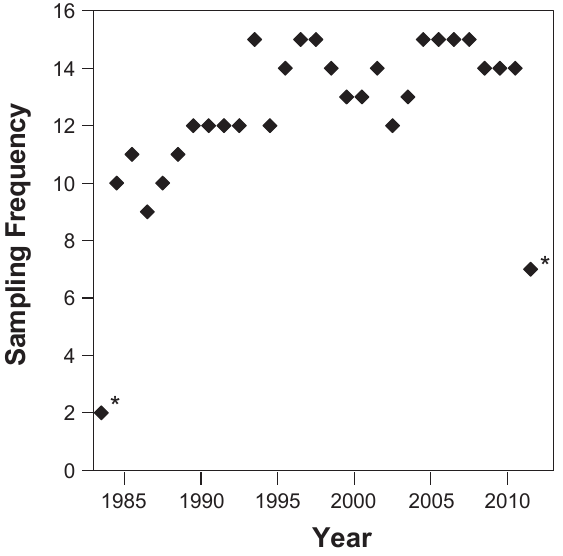
Fig. 1 Fig. 1. Sampling frequency or number of cruises each year when seawater carbonate chemistry and other parameters were collected. From September 1988, only BATS cruises are shown with Hydro- station S cruise beforehand. The * symbol denotes years when the full year was not sampled.